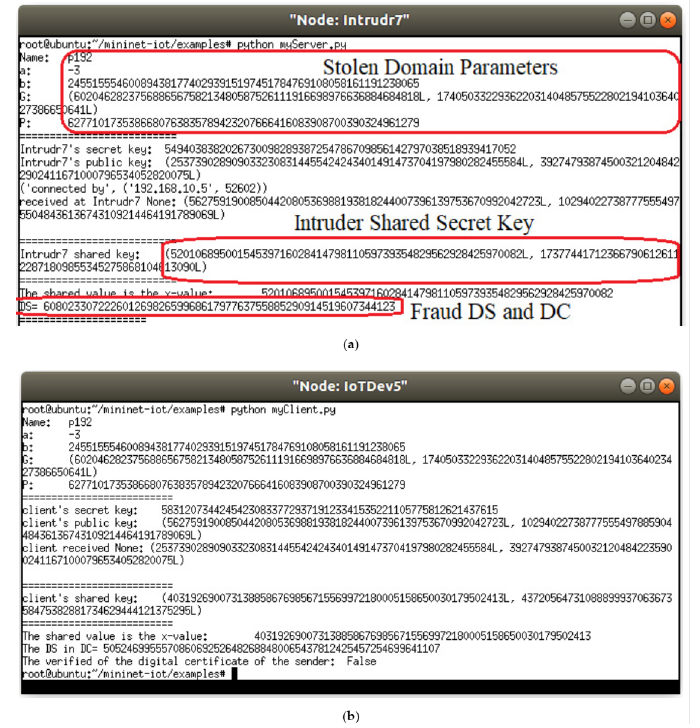
Figure 5. Countermeasures spoofing attack for gateway DC ( a ) Intruder 7; ( b )